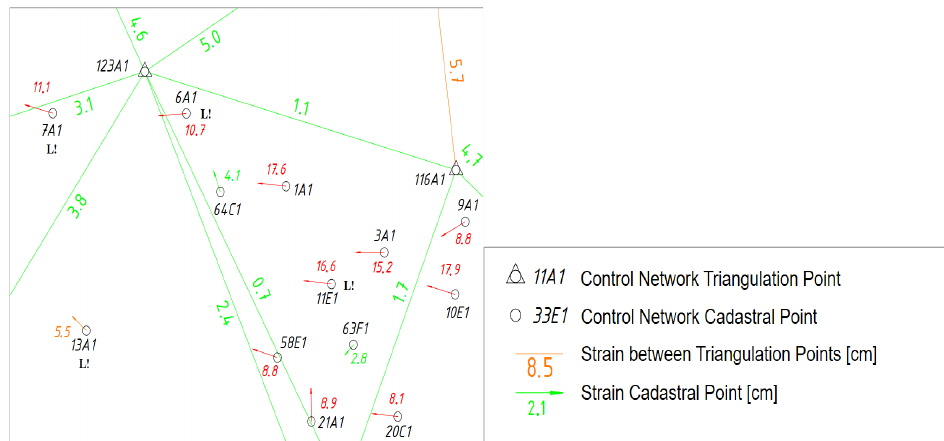
Figure 3. Distortion of the control points in Gallneukirchen. The red arrows show the direction and amount of large distortions (data: BEV). Table 1. Residuals of control points after conformal transformation.